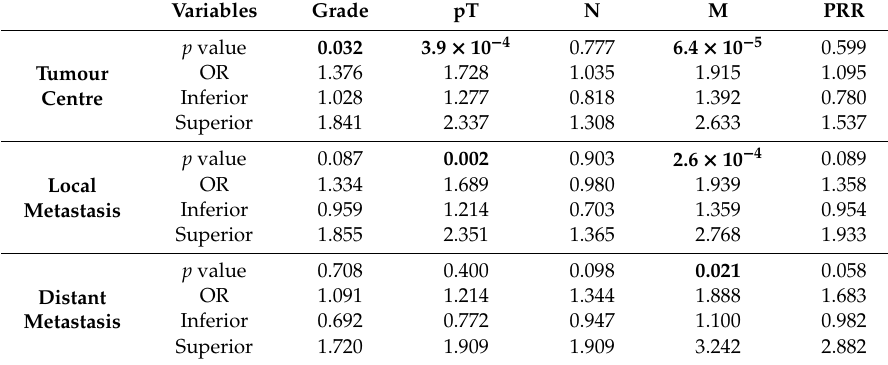
Table 5. Multivariate analysis (Cox regression model) of clinical and pathological variables and PRR expression in the centre of primary tumours and local and distant metastases for CRC patients’ overall survival prediction. Odds ratios (ORs) and inferior and superior confidence intervals (CIs) are also included. A 95% CI for OR was considered. Statistically significant values are highlighted in